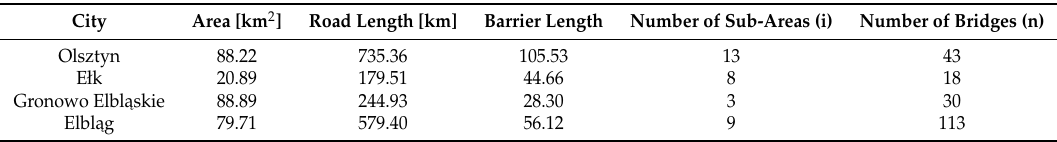
Table 1. Characteristics of the tested